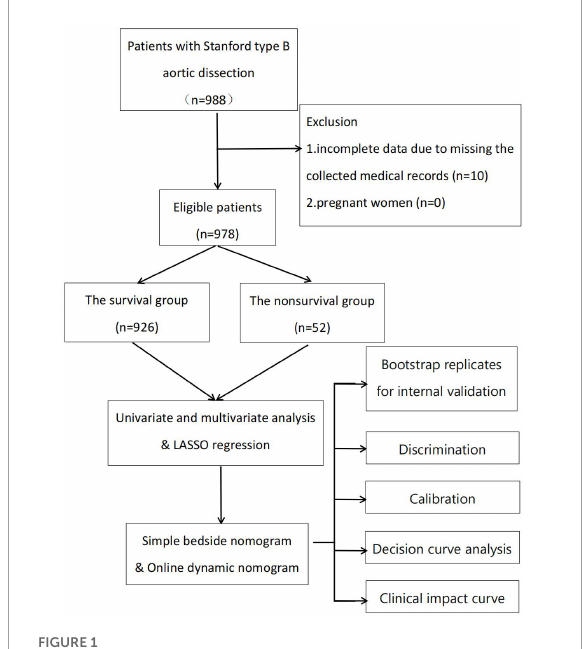
FIGURE1 Flow chart of the study. LASSO, least absolute shrinkage and selection